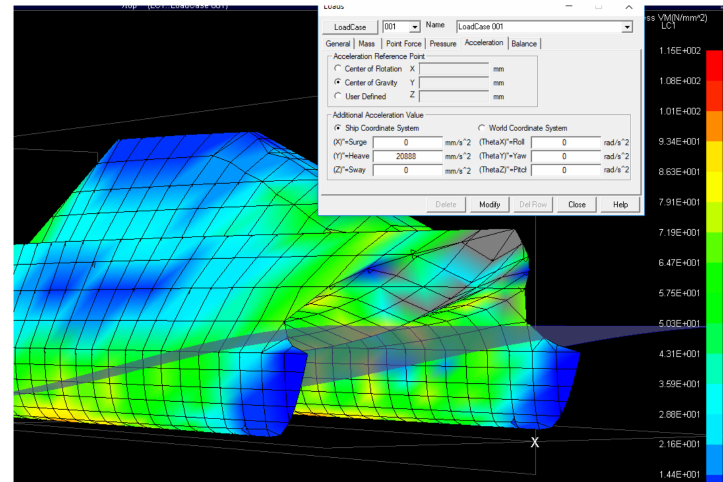
Figure 8. Additional acceleration applied due to the related sea state.